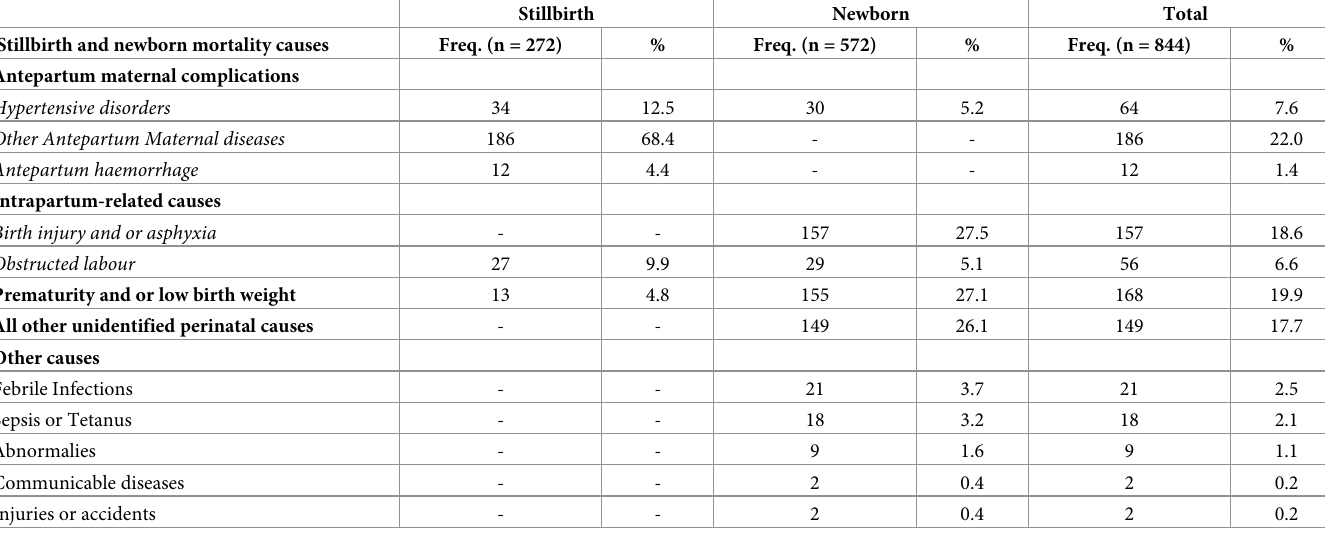
Table 3. Stillbirth and new-born mortality causes using 2005–2015 Iganga-Mayuge verbal autopsy